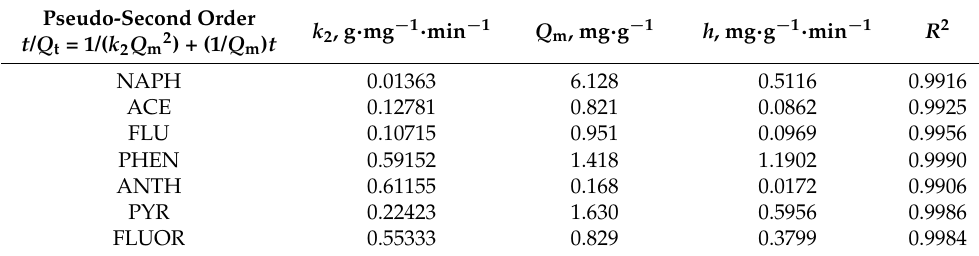
Table 2. Kinetic parameters for the biosorption of PAHs onto biomass using the pseudo-second order